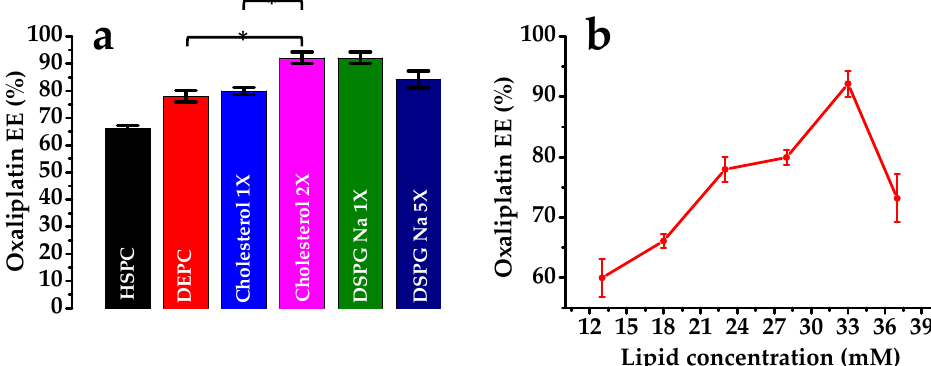
Figure 2. Effects of lipid composition on the entrapment efficiency (% EE) of oxaliplatin on MVLs ( a ) using various lipids and ( b ) using various concentrations (mM) of the total lipids. Data are presented as the mean ± SD ( n = 3). *Statistically significant. HSPC: hydrogenated soybean phosphatidylcholine, DEPC: 1,2-dierucoyl-sn-glycero-3-phosphocholine, and DSPG Na: 1,2-disteraroyl-sn-glycero-3-phospho-rac-glycerol-sodium salt.